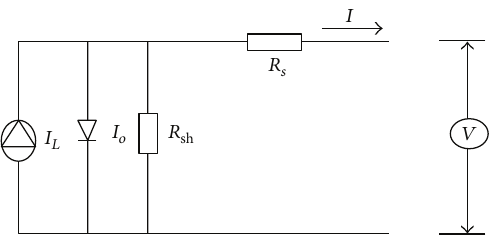
Figure 1: Equivalent electrical circuit model of a PV